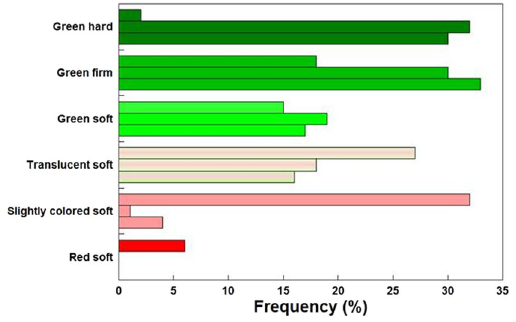
Figure 5. Frequency distribution as per six different berry ripening categories recorded on 14 July on a 100- berry sample per treatment. Within each category, top bar is PS-Access, mid is PS-SG and bottom is FS-SG. Mean soluble solids concentration (°Brix) of each 100-berry sample was 8.64, 6.54 and 6.31 for 72-096, PS- SG and FS-SG,